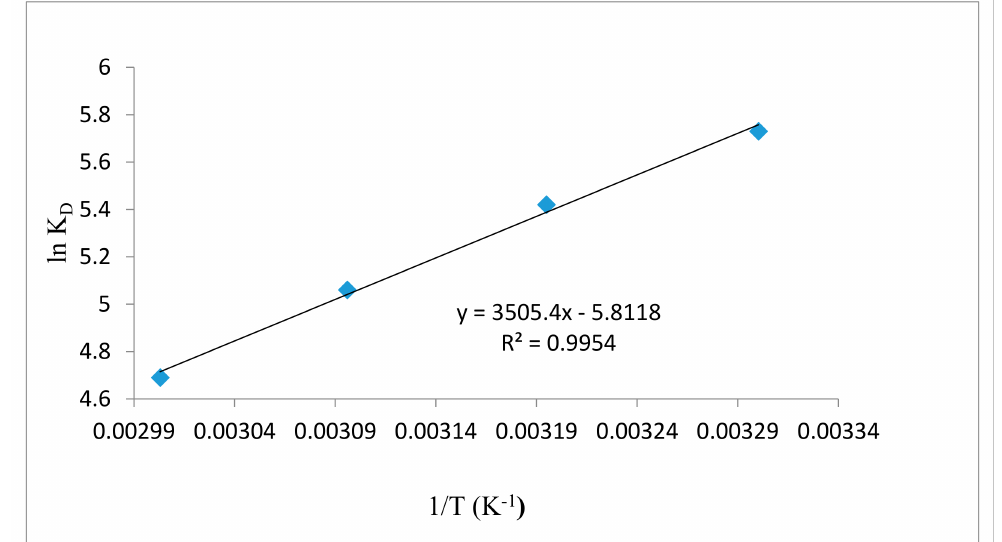
Figure 10. Thermodynamic study for RB dye